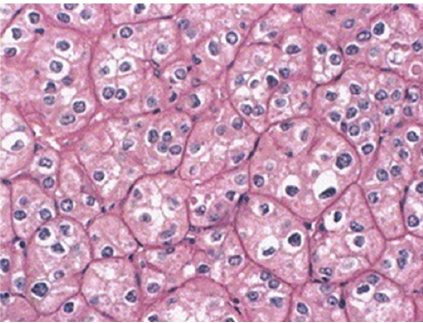
Figure 4: Chromophobe renal cell carcinoma on hematoxylin and eosin stain